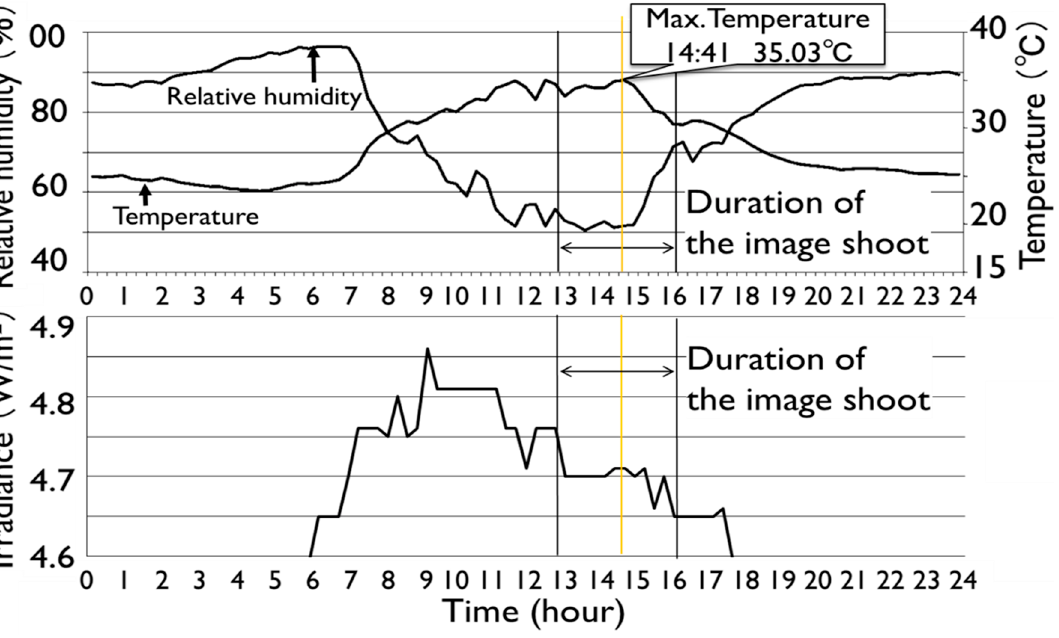
Figure 2. Cultivation condition of orange trees.